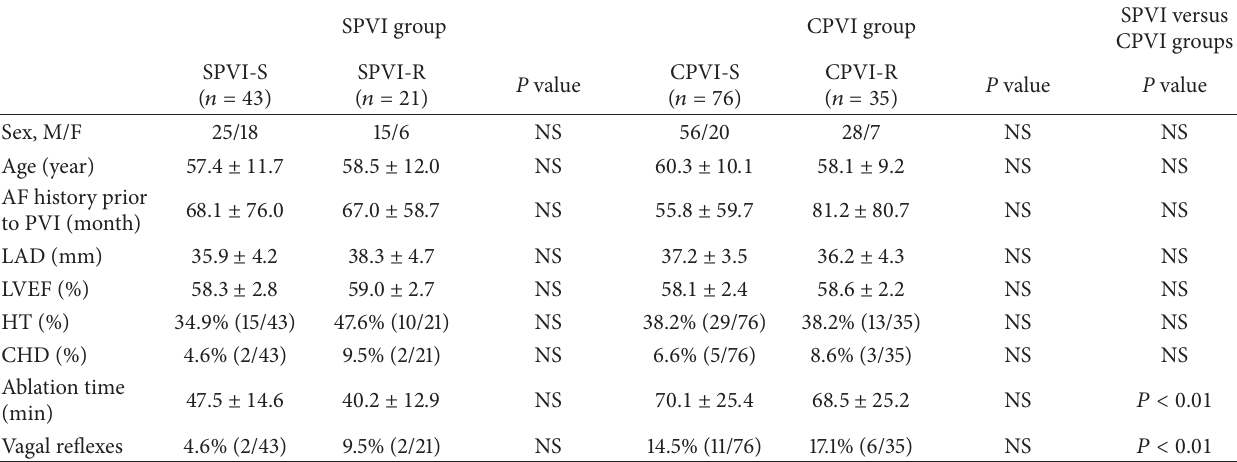
Table 1: Baseline and procedural characteristics of